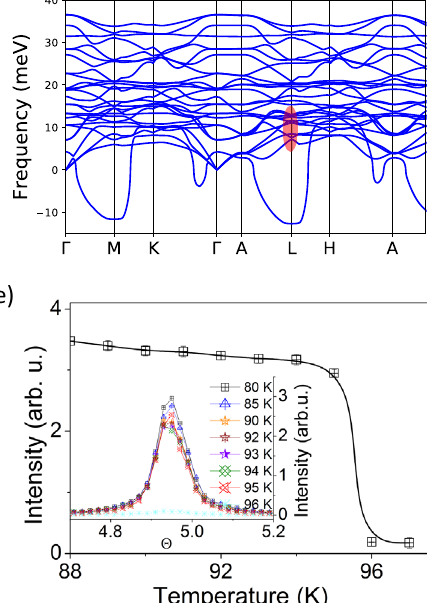
Fig. 1 | Charge density wave in CsV 3 Sb 5 . a Chemical structure of AV 3 Sb 5 . Orange, red and cyan balls stand for A (Cs, Rb), V and Sb atoms. b Top view of the kagome structure, showing the V-kagome net interlaced with the Sb atoms. c Calculated phonon dispersions of fully-relaxed CsV 3 Sb 5 . Soft modes are observed at M and L .